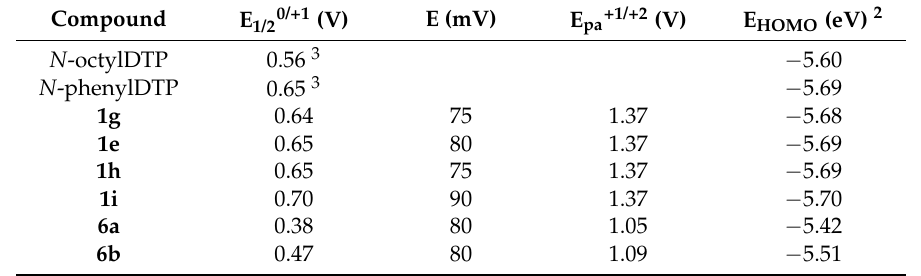
Table 3. Electrochemical data for various bis[1]benzothieno[3,2- b :2 (cid:48) ,3 (cid:48) - d ]pyrroles and dithieno[3,2- b :2 (cid:48) , 3 (cid:48) - d ]pyrroles.